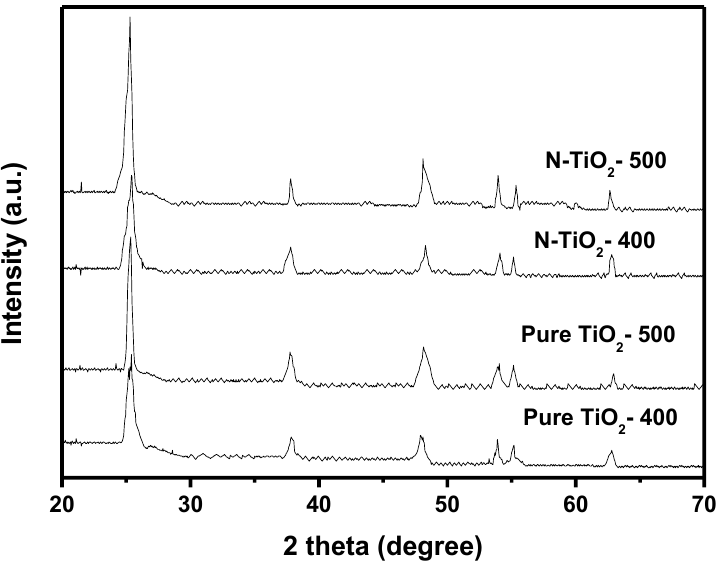
Figure 5. The XRD spectrum of N-TiO 2 and pure TiO 2 .